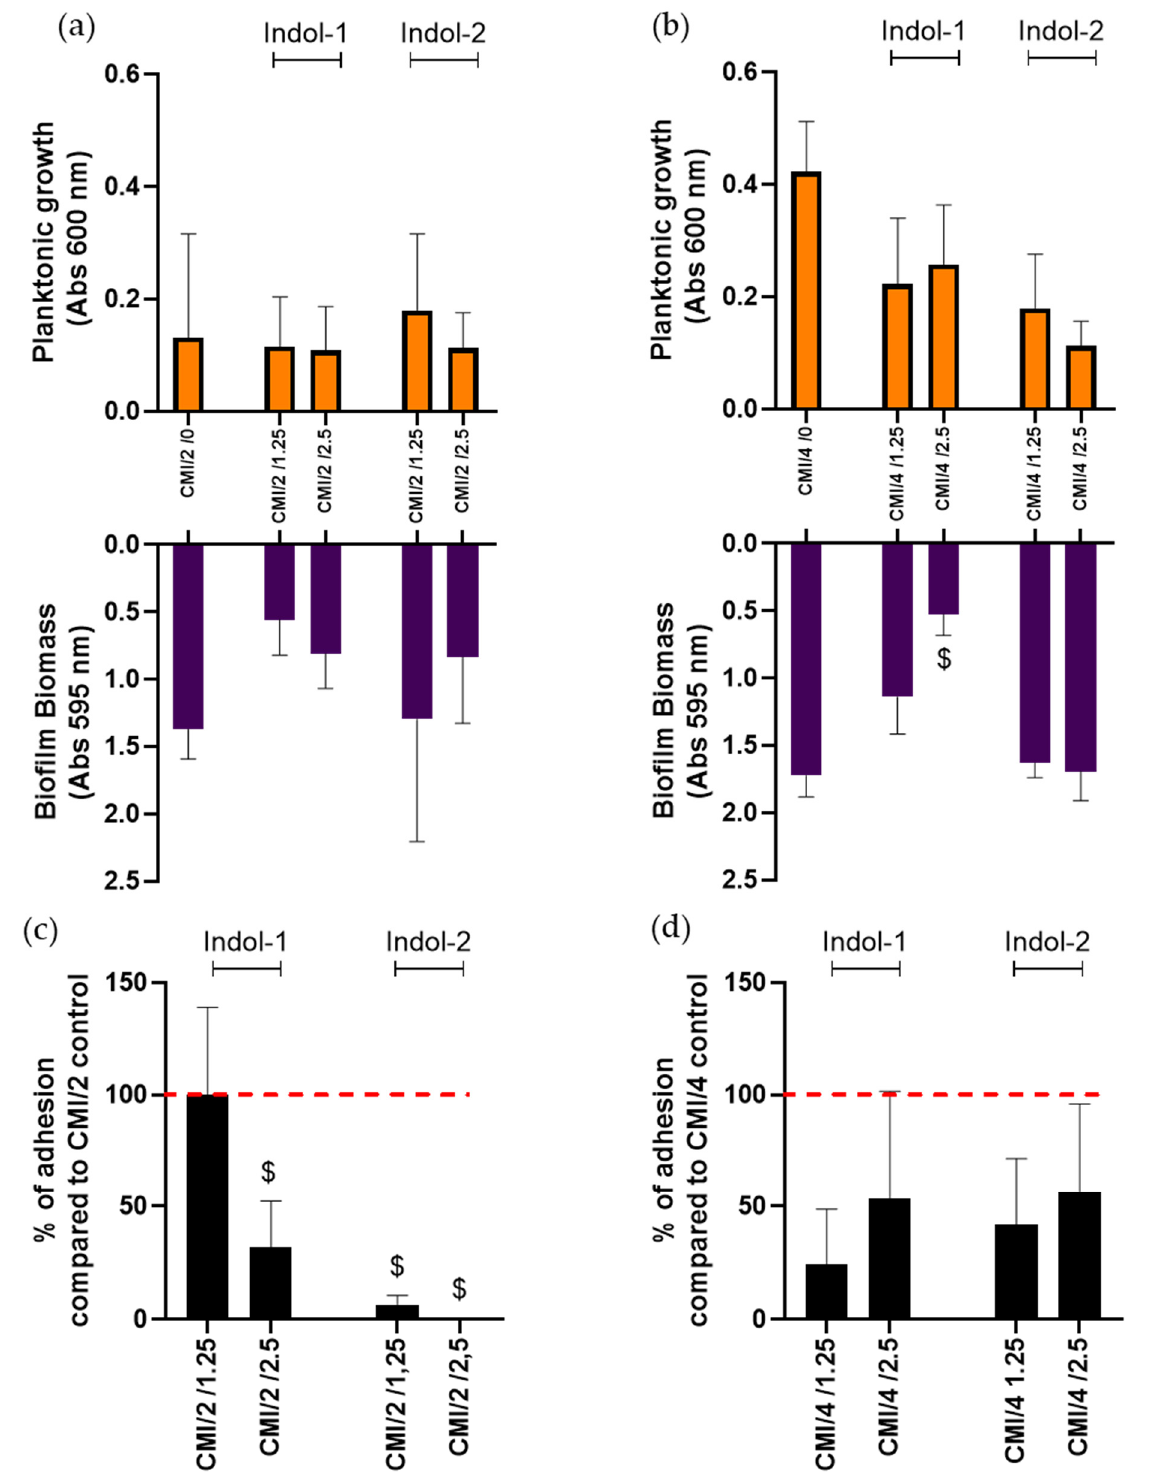
Figure 4. Sub-MIC Ciprofloxacin treatment combined with Indol molecules against P. aeruginosa . Ciprofloxacin concentration is annotated in first position and indoquinoline in second position in abscissa legend. ( a , b ) Planktonic growth and biofilm biomass after 24 h: ( a ) MIC/2 of ciprofloxacin (0.315 µg/mL); ( b ) MIC/4 of ciprofloxacin (0.1575 µg/mL). MIC ciprofloxacin appeared in red square. ( c , d ) Percentage of adherent cells after ciprofloxacin + Indol treatment rationalized to the quantity of adherent cells under ciprofloxacin treatment alone. ( c ) MIC/2 of ciprofloxacin. ( d ) MIC/4 of ciprofloxacin. Mann-Whitney test ($; p < 0.05, significant vs. control).